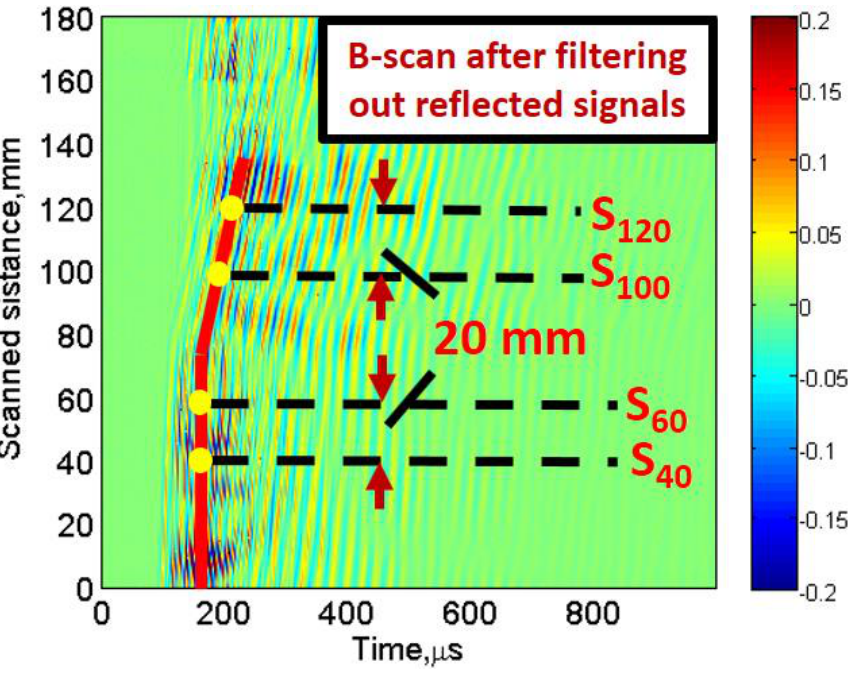
Figure 6. Reconstructed B-scan by considering only direct waves.